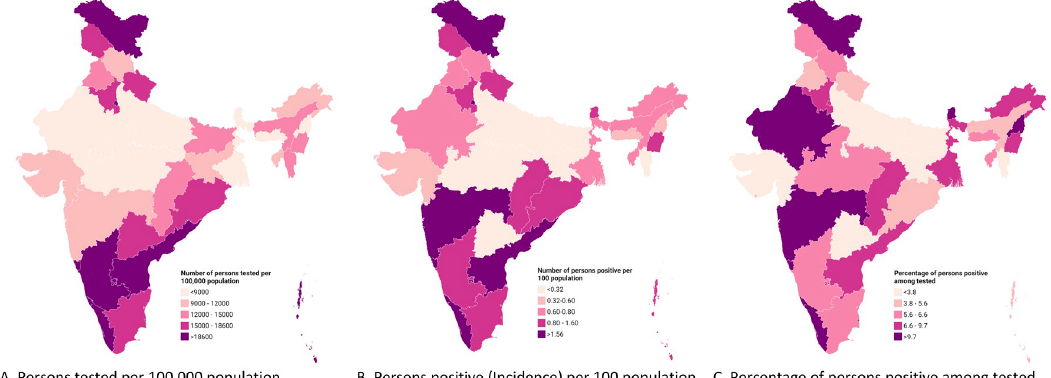
Fig 1. State-wise distribution of COVID-19 testing, incidence and positivity among tested individuals, India (March 2020 to January